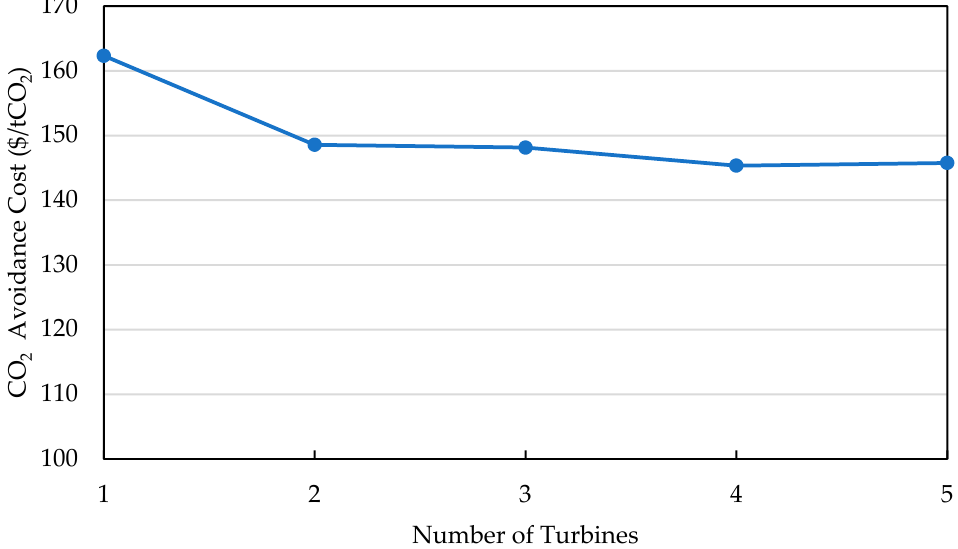
Figure 11. Operating and Maintenance costs of co-fired 5-turbine NGCC power plants.